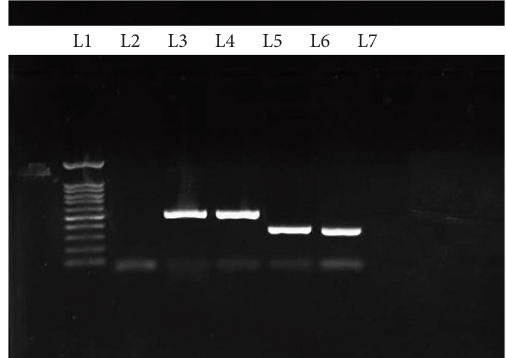
Figure 2: Gel electrophoresis of the PCR products. L-1: 100-bp ladder; L-2: negative control of ermX and mefA genes; L-3: positive control for C. mintissimum containing the ermX ; L-4: ermX gene; L-5: positive control of mefA ; L-6: mefA